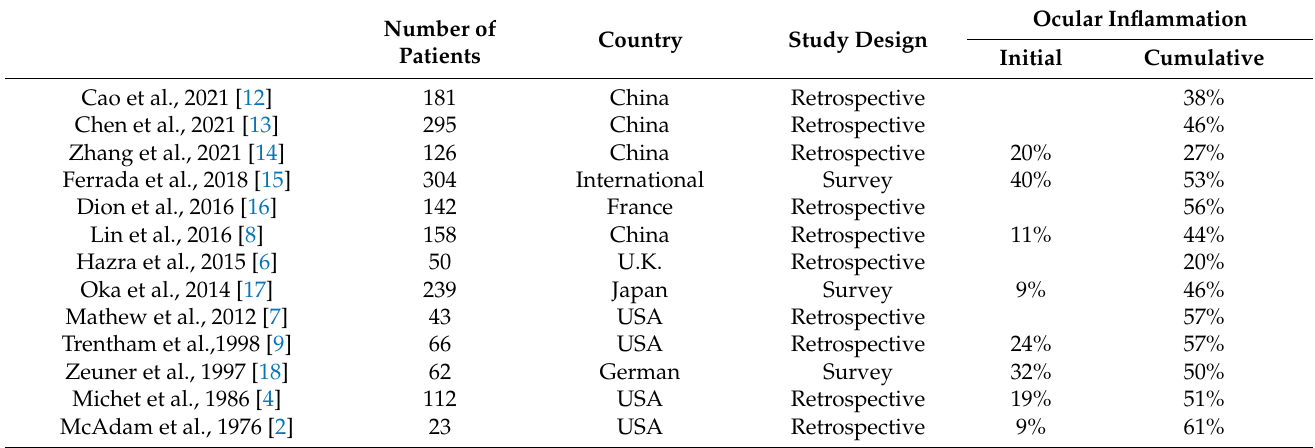
Table 2. Incidence of ocular involvement in cases of RPC in a large case